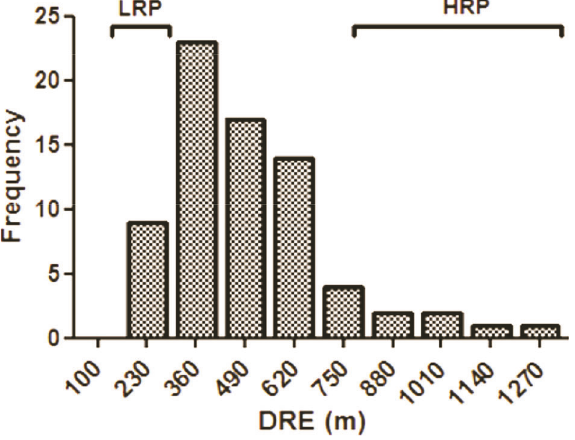
Figure 1. Frequency distribution of rats submitted to a progres- sive exercise test. The frequency is shown as total distance run to exhaustion (DRE; n=73 rats). LRP: Low running performance (9 rats); HRP: High running performance (9